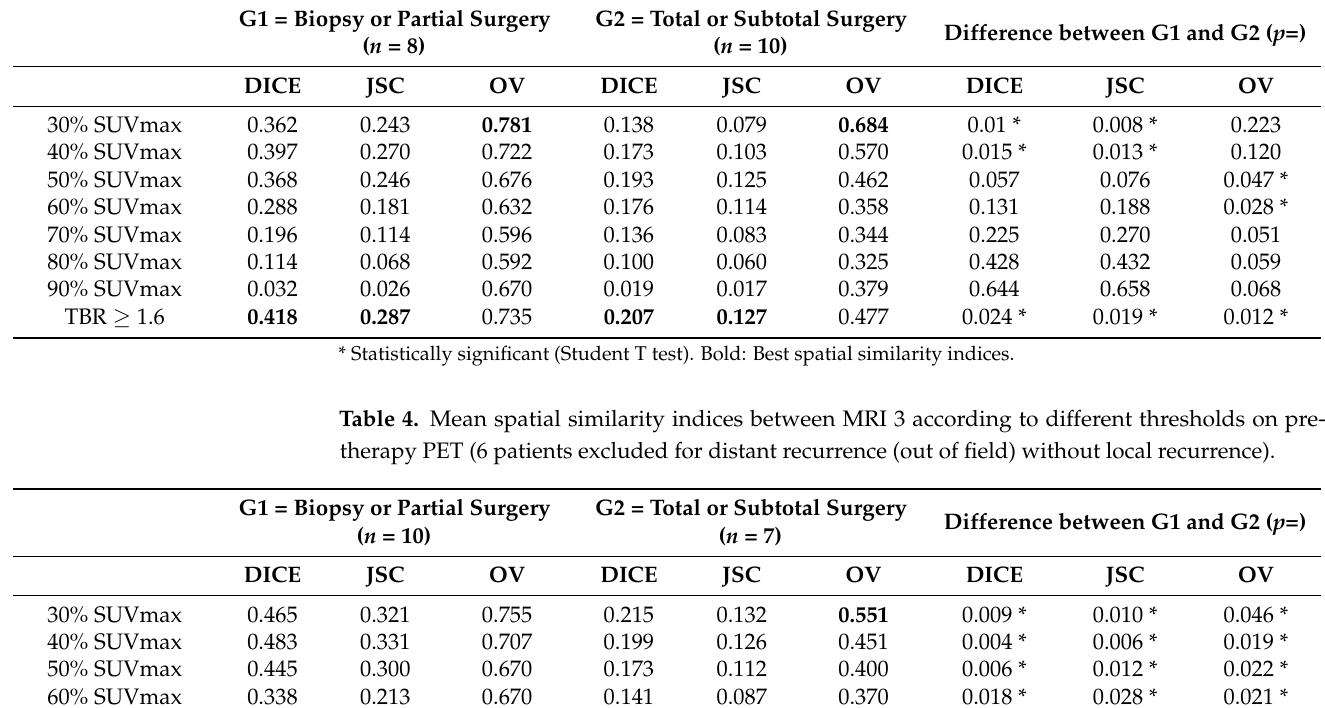
Table 3. Mean spatial similarity indices between MRI 2 according to different pre-therapy PET thresholds (5 patients excluded due to none MRI 2).